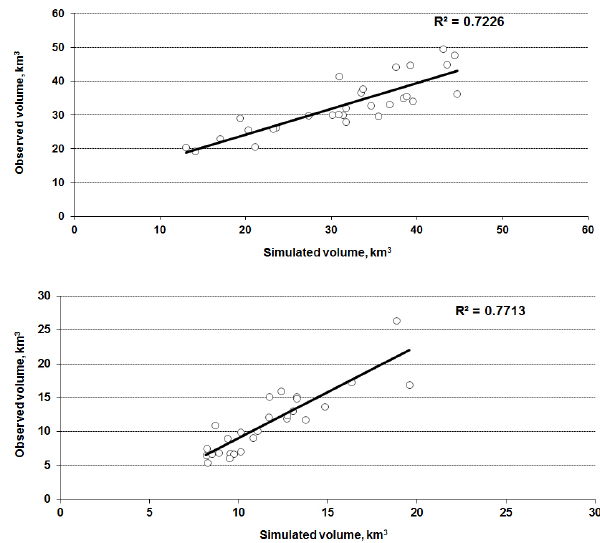
Figure 3. Observed and simulated volumes of seasonal inflow into the Cheboksary reservoir (top – spring freshet season; bottom – summer low-water